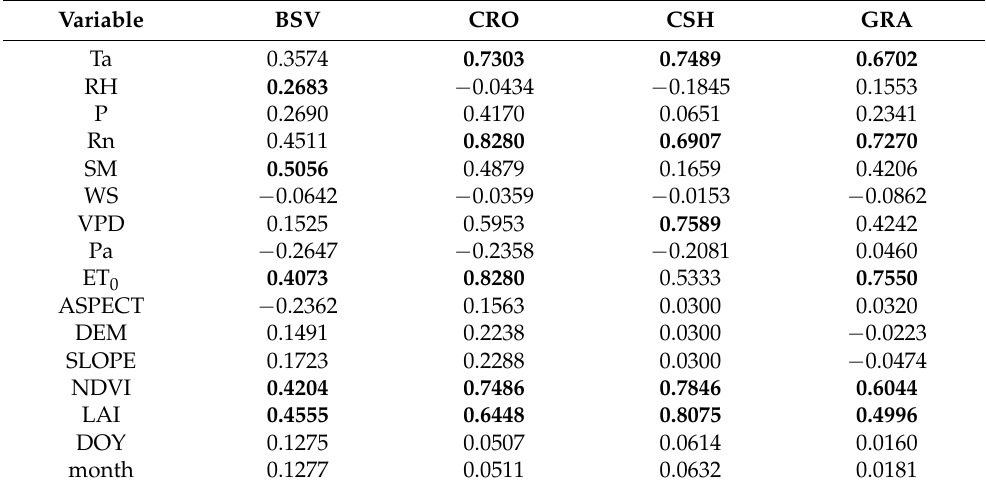
Table 5. PPMCC between driving variables and latent heat flux for primary land cover